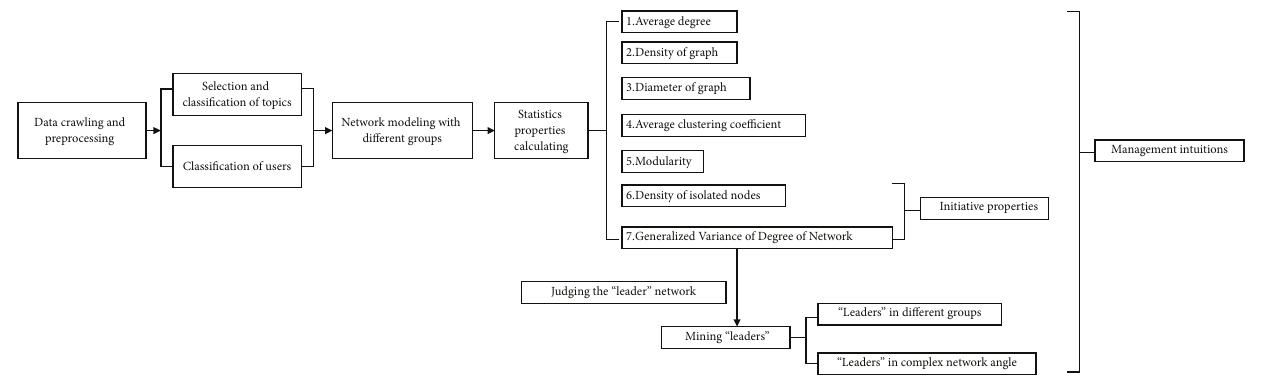
Figure 1: Sketch of the exploration